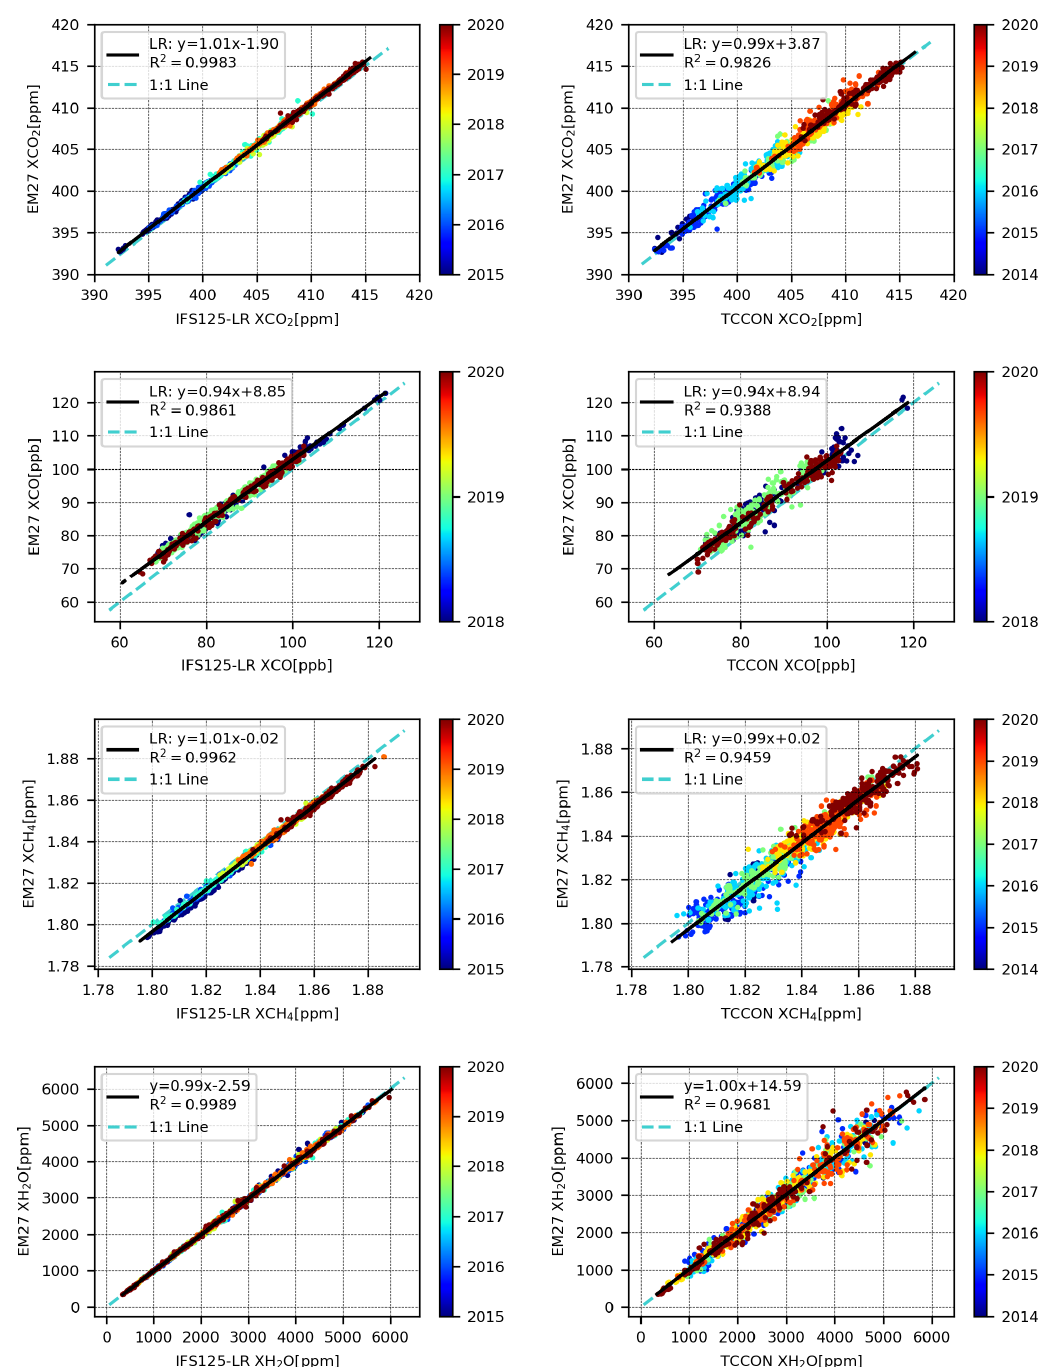
Figure 21. Correlations between XCO 2 , XCO, XCH 4 and XH 2 O between the ones retrieved by using the COCCON reference and the IFS125-LR low-resolution data (left panels) and between COCCON reference and TCCON station (right